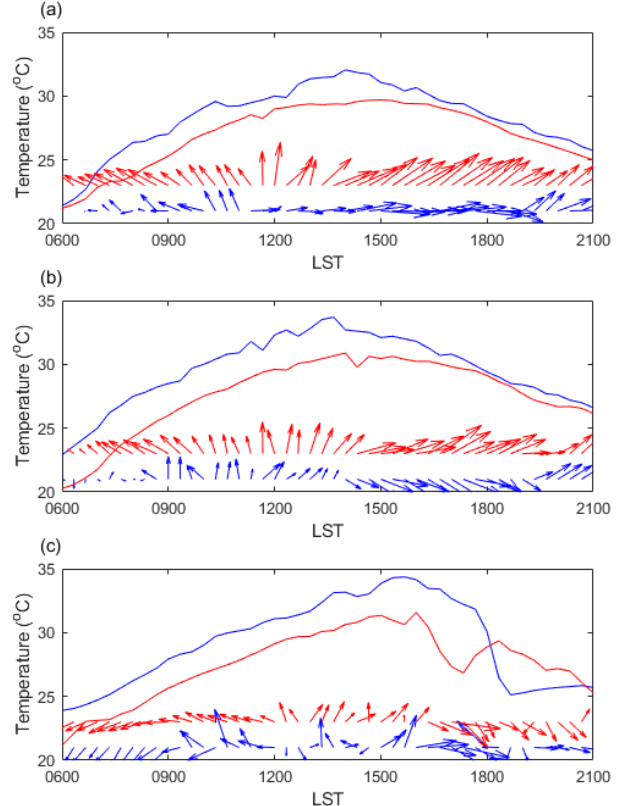
Figure 4. Comparison of 10 m wind vector and 2 m air temperature at ( a ) Gongchongdong, ( b ) Gimpo Airport, and ( c ) Seoul station from 0600 to 2100 LST on 6 July 2017 between CNTL (red) and observation (blue).